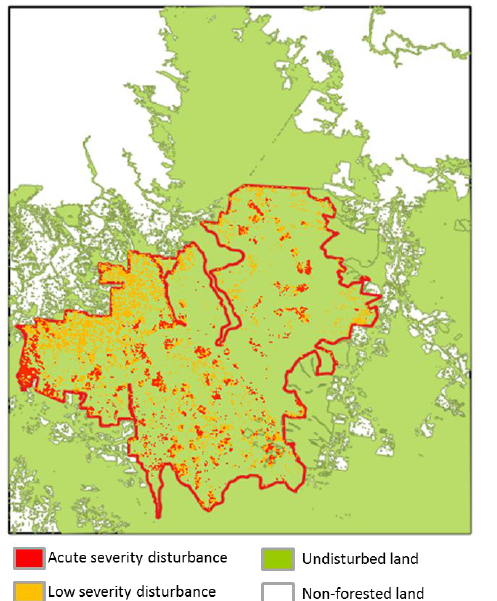
Figure 4: Map derived in the disturbance classification phase showing undisturbed areas, acute severity disturbances, and low severity disturbances.